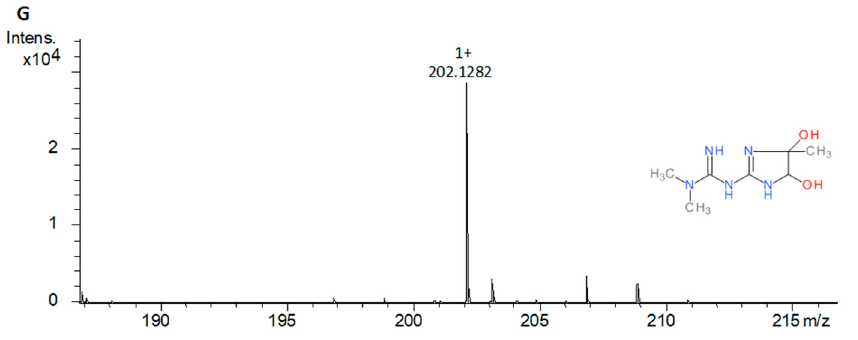
Figure 4. The mass spectra of methylglyoxal adducts and their proposed chemical structure: ( A ), quercetin mono-MGO adduct (373 Da); ( B ), quercetin di-MGO adduct (445 Da); ( C ), rutin mono-MGO adduct (681 Da); ( D ), rutin di-MGO adduct (753 Da); ( E ), galegine mono-MGO adduct (200 Da); ( F ), hydroxygalegine mono-MGO adduct (216 Da); ( G ), metformin mono-MGO adduct (202 Da).